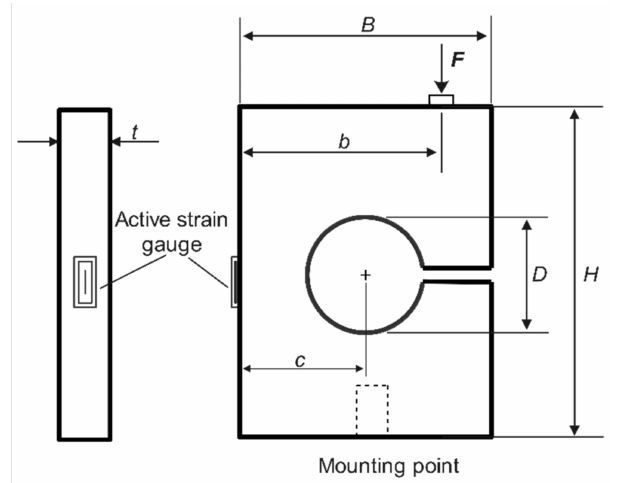
Figure 6. Geometry of the load cell